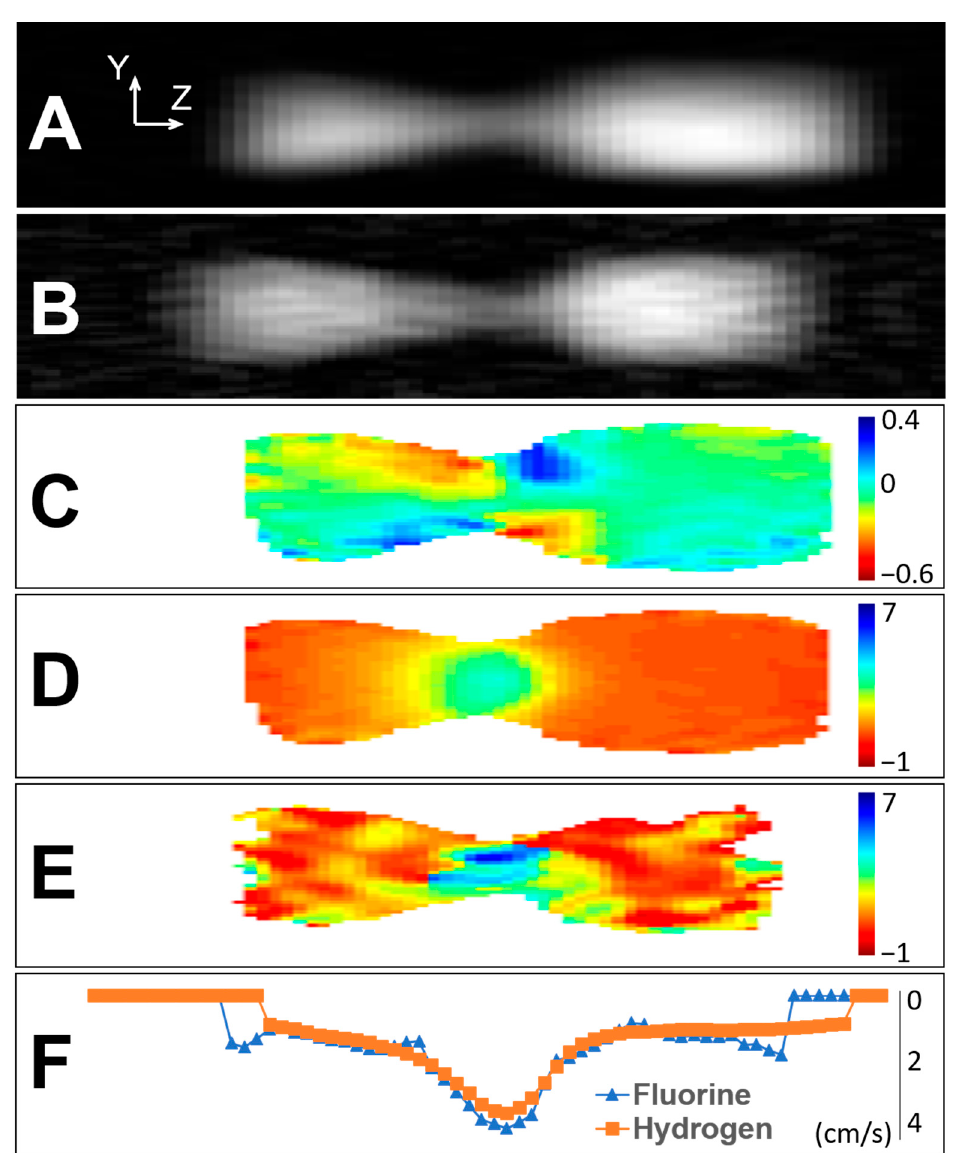
Figure 1. Density and velocity maps of the foam flow for the liquid phase (hydrogen signal) and the gas phase (fluorine signal). ( A ) Density image of the liquid phase. ( B ) Density image of the gas phase. ( C ) Y-component of velocity map of the liquid phase. ( D ) Z-component velocity map of the liquid phase. ( E ) Z-component velocity map of the gas phase. (F ) Z-component of velocity for both phases, averaged across the width of the pipe. All speeds are in units of cm/s, and bulk flow is from left to right. Uncertainty in speed values was estimated from variations in speed in a region downstream from the constriction throat where speed should be uniform. Uncertainty in speed for ( D ) is ± 0.2 cm/s and for ( E ) is ± 1.7 cm/s.